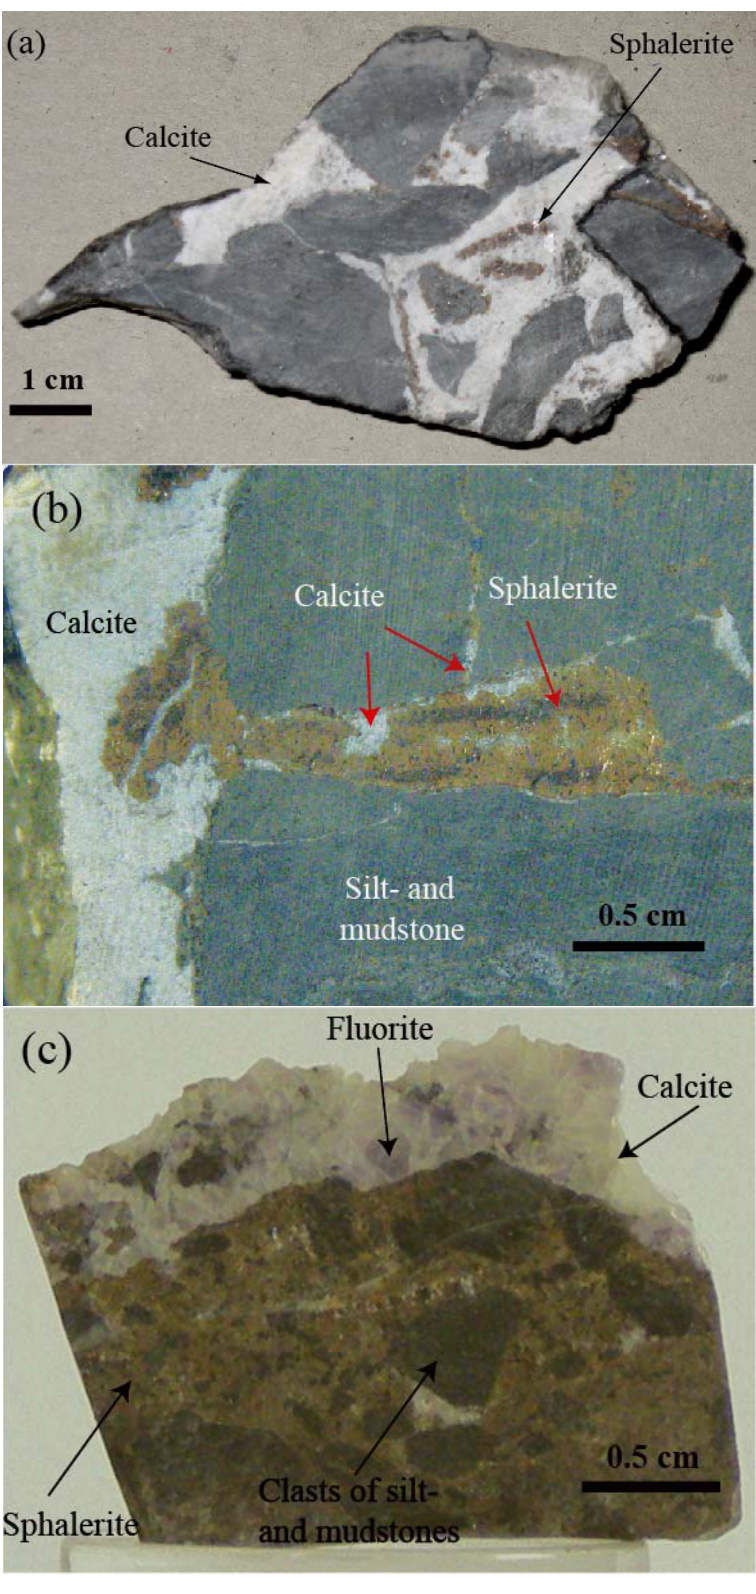
Figure 5. Typical samples of the studied fracture-controlled Zn-Pb mineralisation: ( a ) breccia-like fractures with sphalerite in a calcite cement (Lagbäcken); ( b ) sphalerite-filled open space with intergrown calcite followed by an overgrowth of coarse-grained calcite (Gubbträsk); ( c ) breccia with coarse-grained sphalerite cement